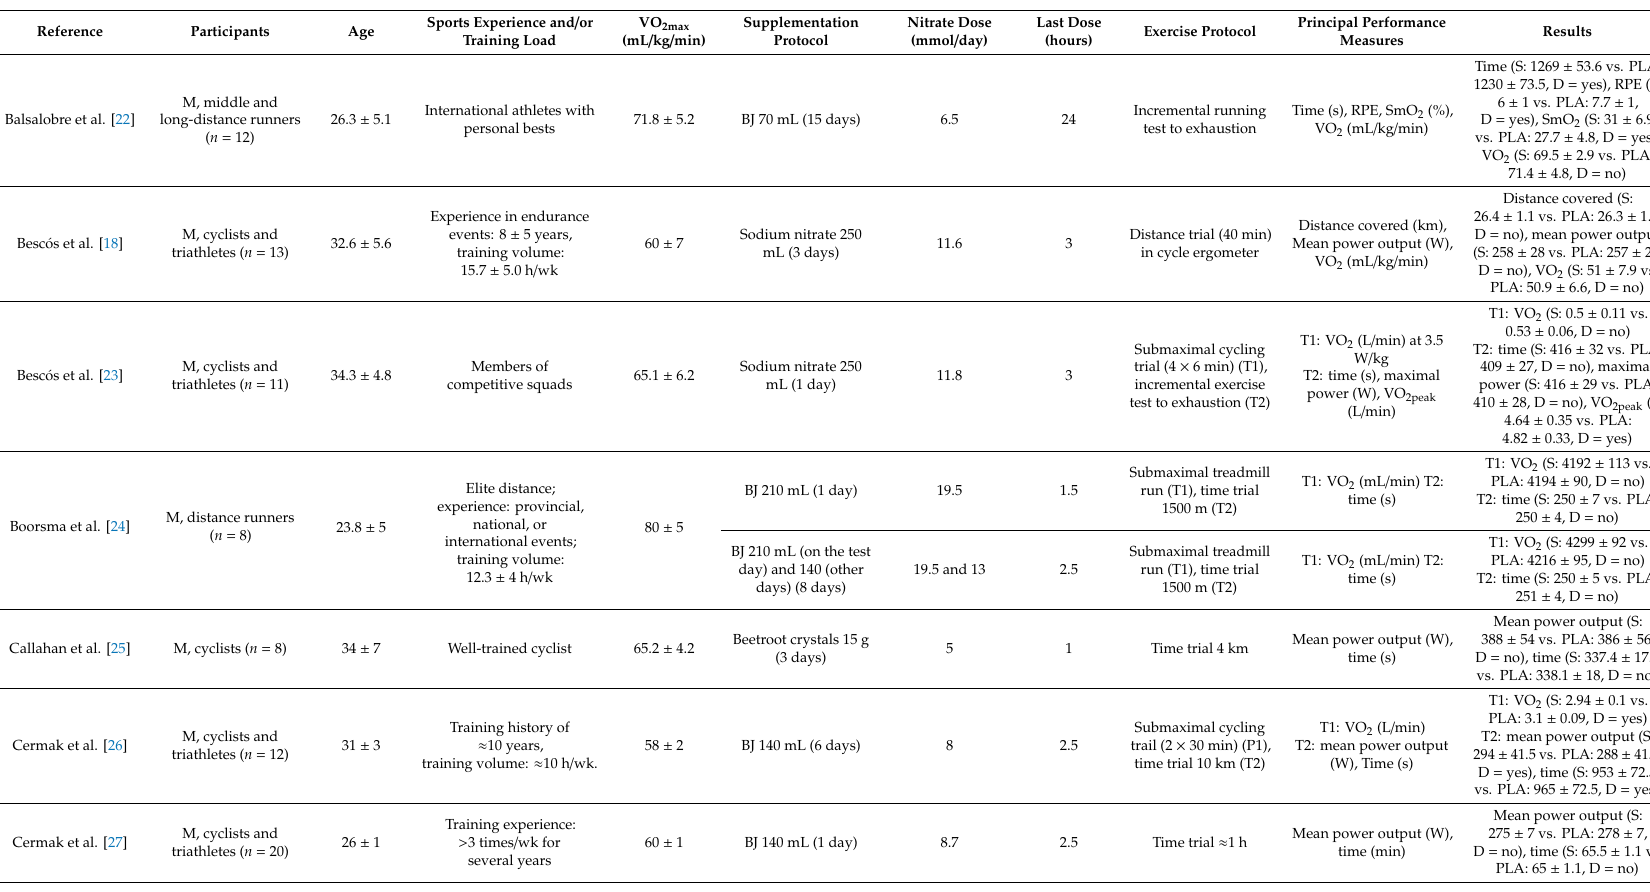
Table 3. Summary of studies reviewed examining the e ff ects of nitrate supplementation on trained athletes of cyclic endurance performance.